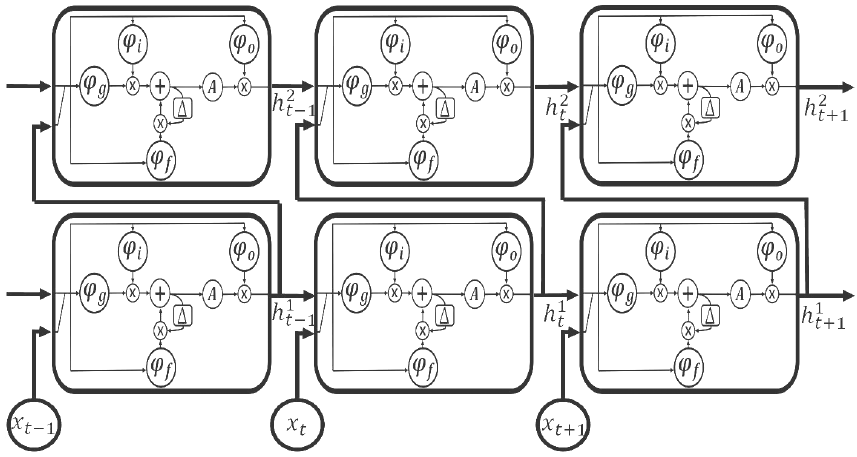
Figure 4. Operation of two-stacked unidirectional LSTM RNN